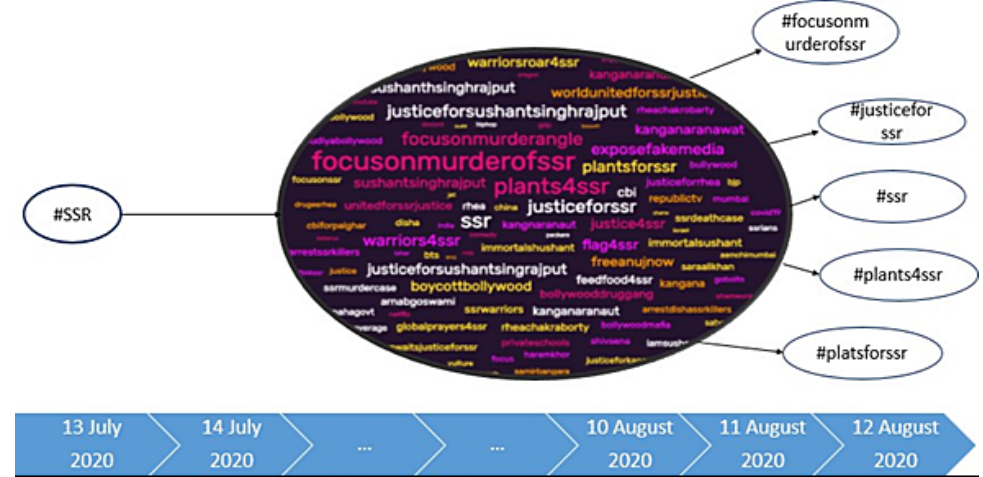
Figure 10. Viral Hashtags detection using initial hashtag #SSR.